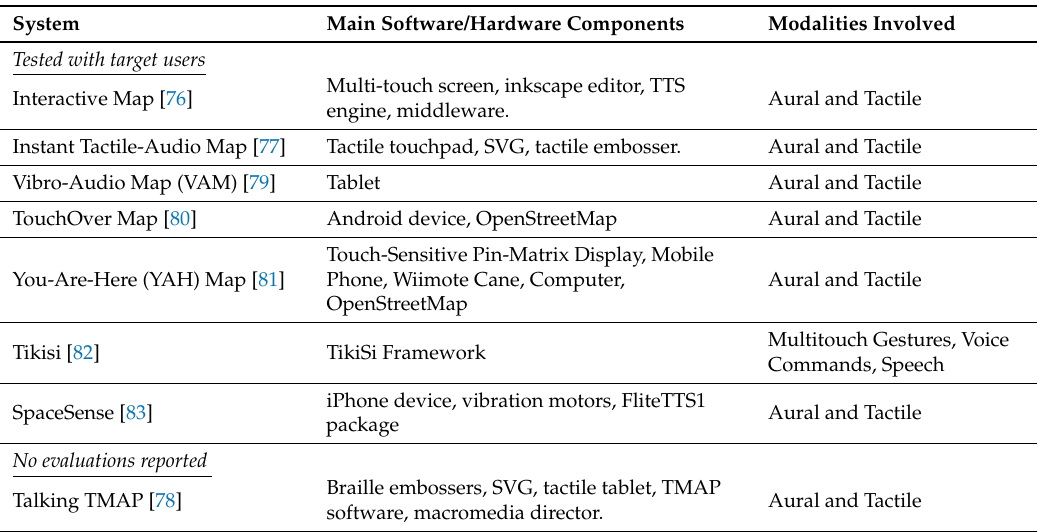
Table 3. Multimodal